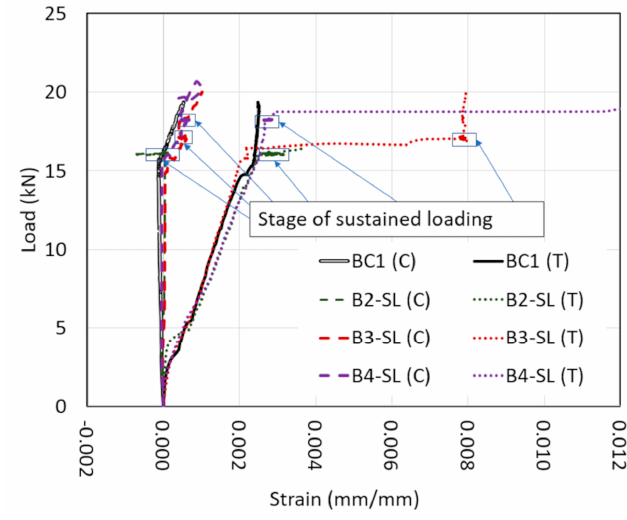
Figure 19. Load vs. strain for beams series I.